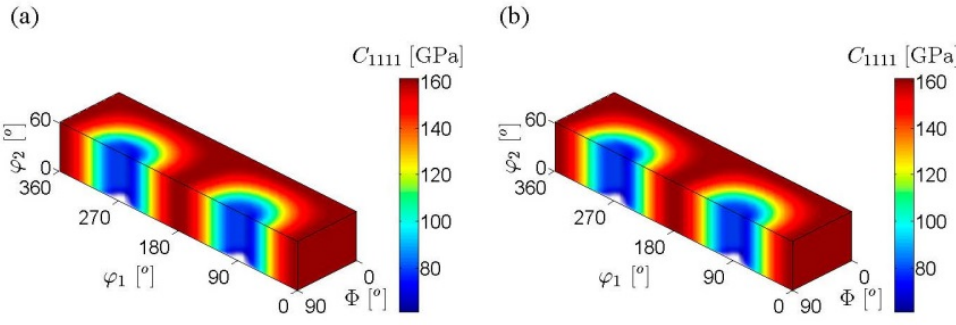
Figure 2. Contour plots of the C 1111 elastic stiffness component in the HCP fundamental zone of the Bunge-Euler space for Zn: ( a ) computed using the non-zero FFTs (Equation (13)) and ( b ) computed directly using Equation (6). The maximum difference between corresponding locations in the two plots is of the order 10 − 6 GPa.